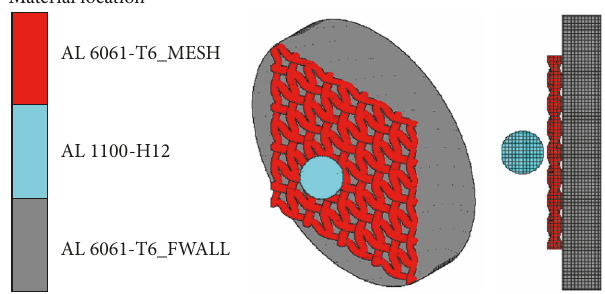
Figure 4: SPH model with mesoscale representation of a mesh